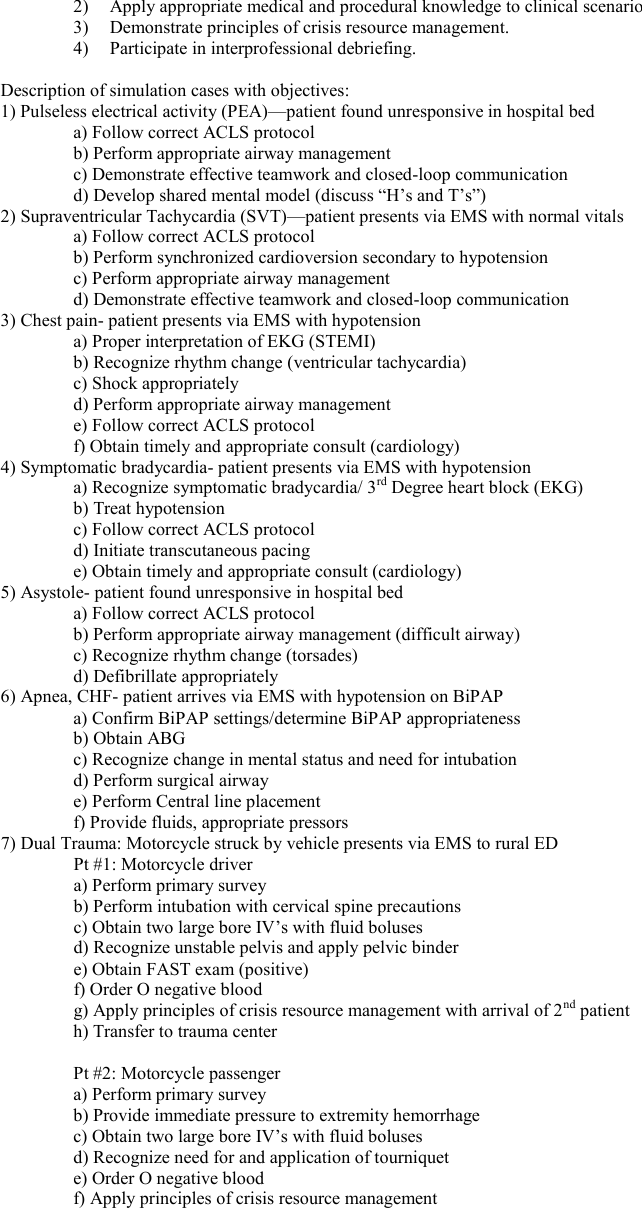
Figure 3. Goals and outline of capstone experience day 2